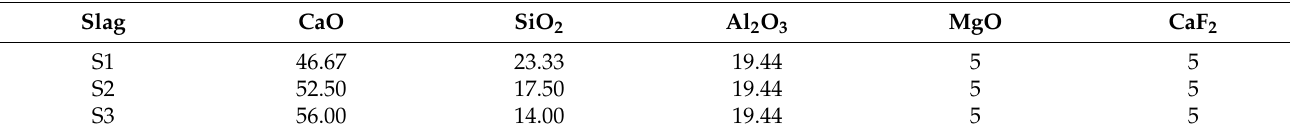
Table 3. Chemical composition of the steel samples following the metal/slag reaction (mass percentage).